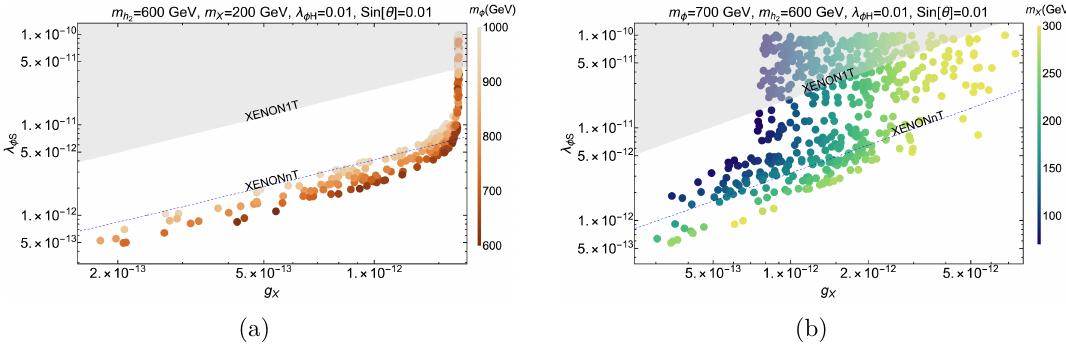
Figure 21 . Scan in g X − λ φS plane when both WIMP and FIMP components add to observed relic density, Ω X h 2 + Ω φ h 2 = 0 . 1200 ± 0 . 0012 , simultaneously addressing other constraints when ≥ 2 m X . In figure 21(a), we both freeze in and freeze out occur aEWSB in kinematic region m h 2 keep FIMP mass fixed at m X = 200 GeV and vary WIMP mass m φ as shown in the SiennaTones colour bar. In figure 21(b), we keep WIMP mass m φ = 700 GeV fixed and vary FIMP mass ( m X ) as shown by the BlueGreenYellow colour bar. Other parameters kept fixed are mentioned in the figure heading. Direct search constraint from XENON1T is shown by grey shaded regions, while the future sensitivity of XENONnT is shown by blue dotted